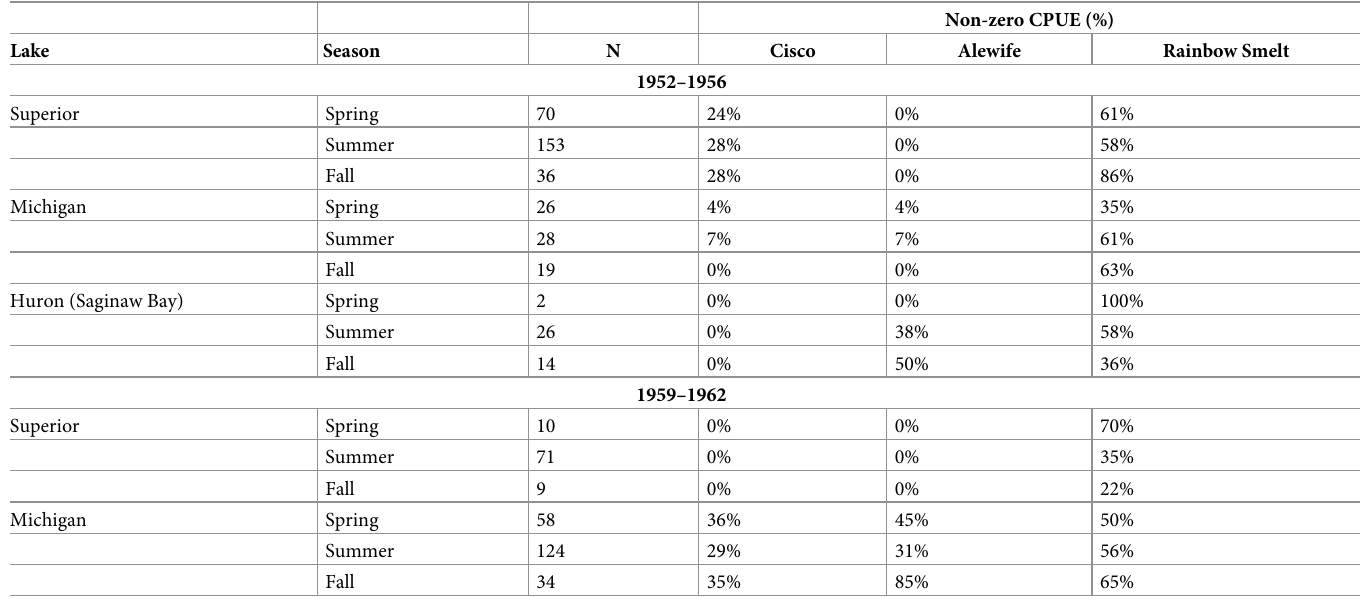
Table 3. Percentages of non-zero values in observed bottom-trawl catch per unit effort (CPUE) for Cisco, Alewife, and Rainbow Smelt in the upper Great